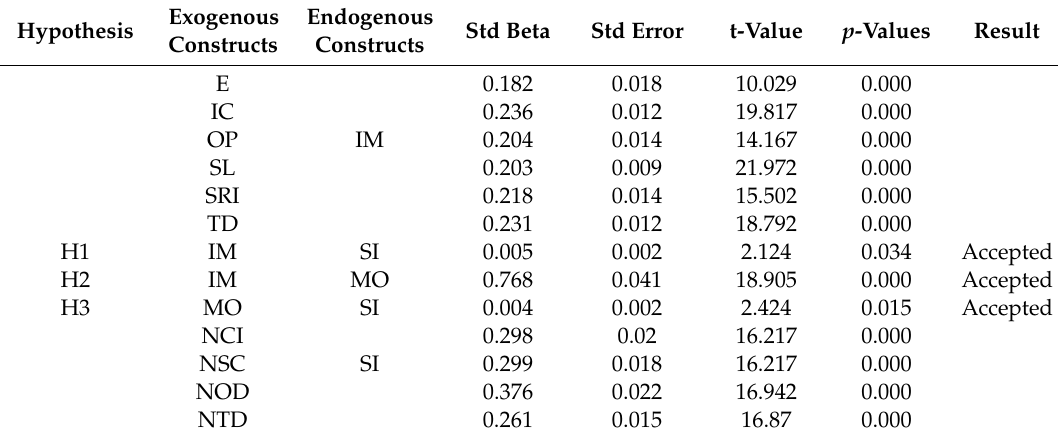
Table 6. The significance of path coe ffi cients for structural model evaluation.